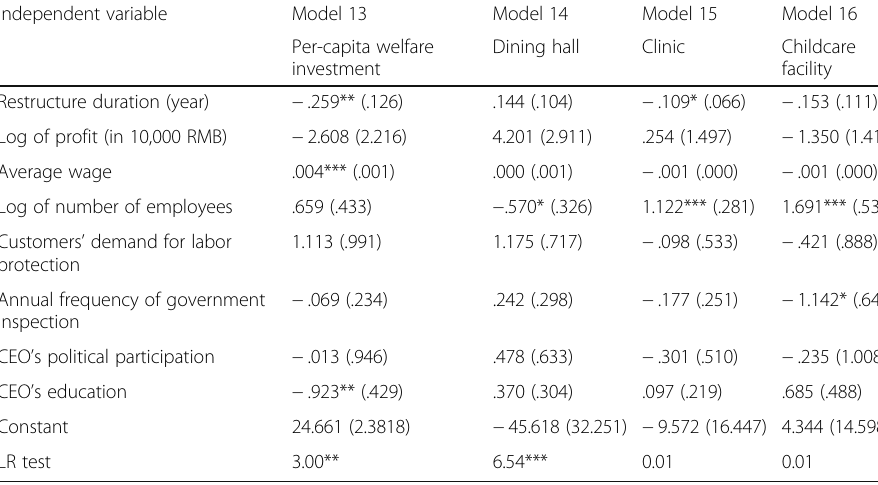
Table 5 Influence of restructure duration on organizational welfare practices Independent